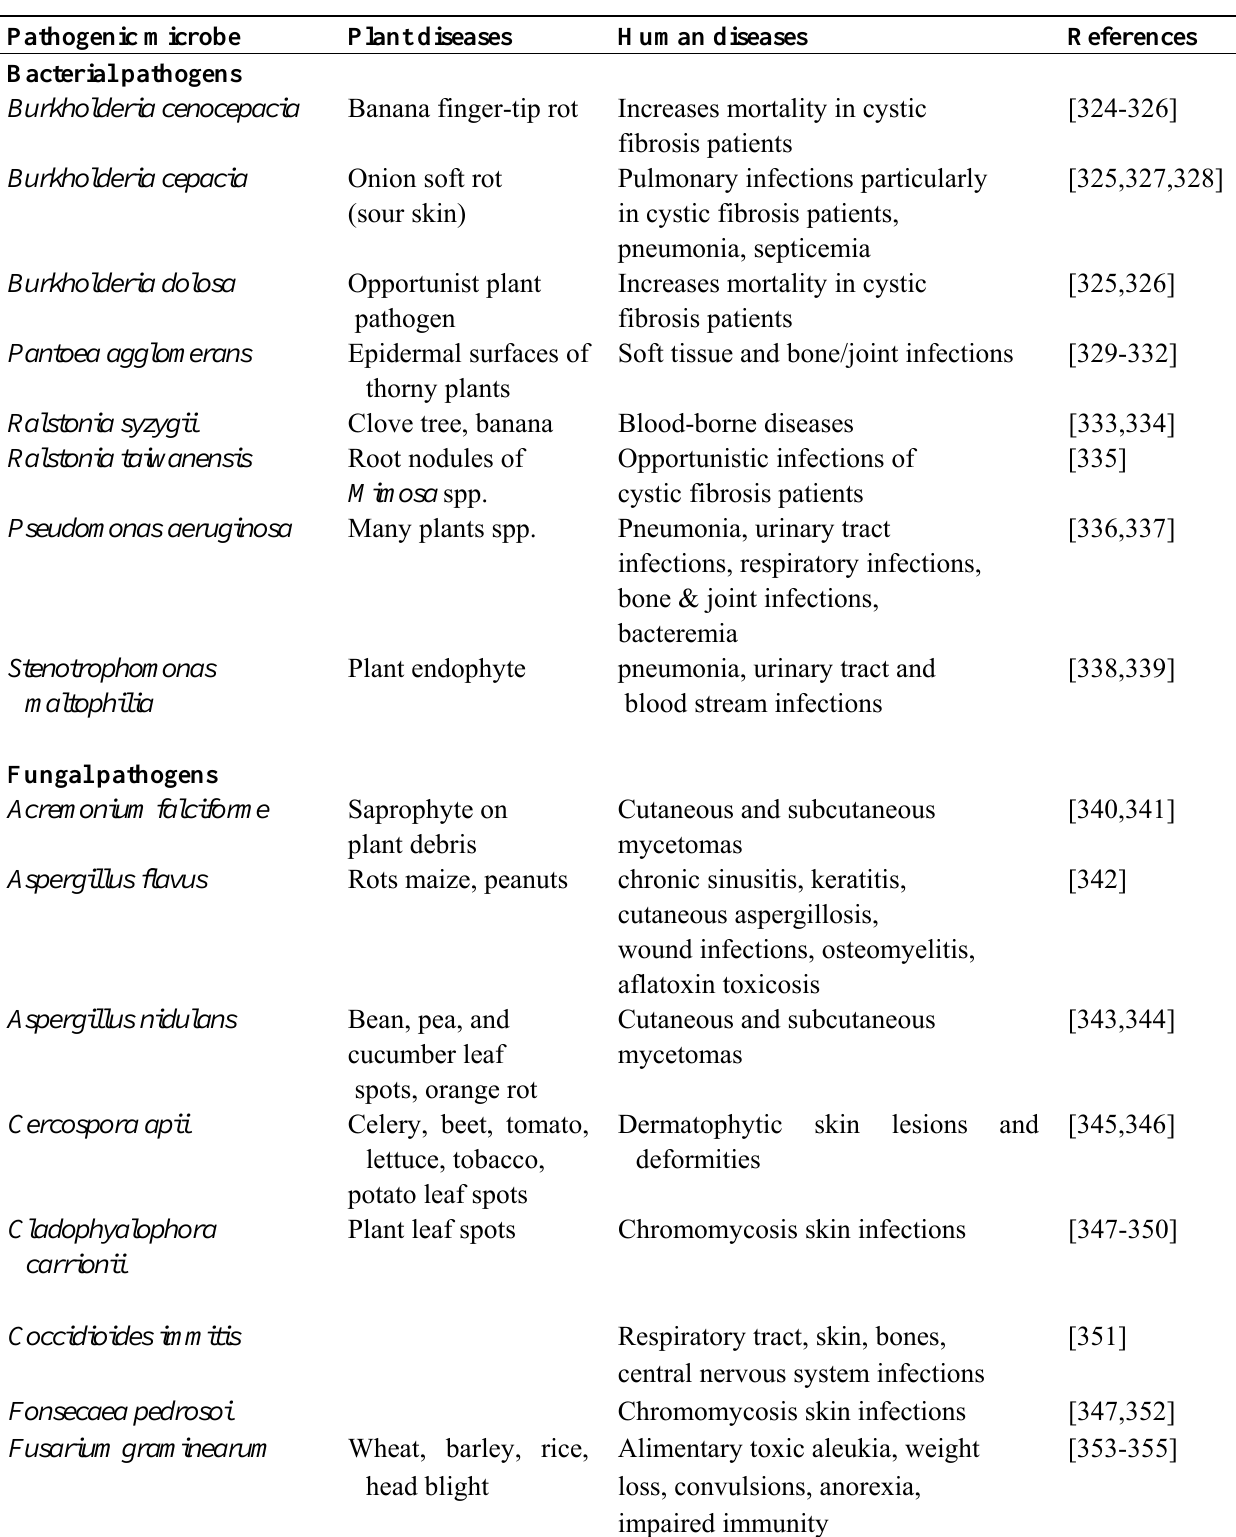
Table 5. Nosocomial opportunistic pathogens detectable with e-nose instruments as disease-causing agents of both plants and humans in the hospital